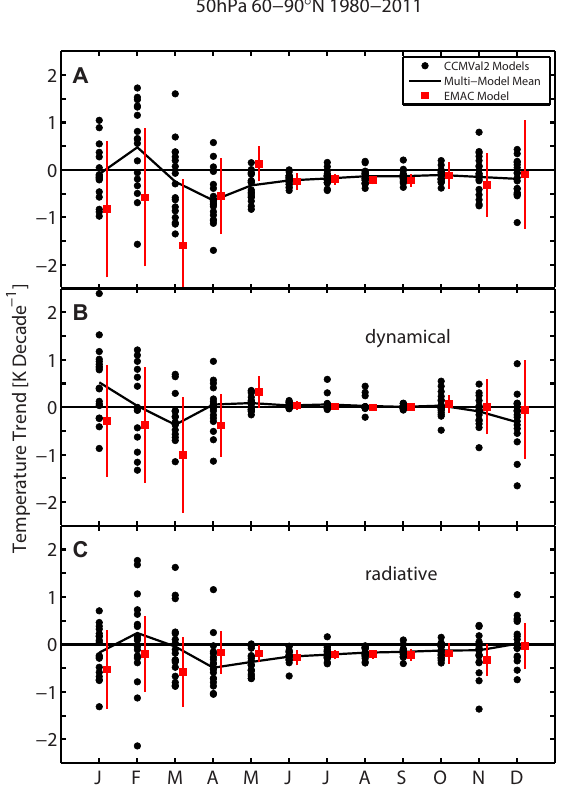
Fig. 3. Arctic temperature trends per decade at 50hPa for each month from EMAC (red) and CCMVal2 models (black) for the years 1980–2011. The figure shows the area-weighted average over 60–90 ◦ N. (A) Temperature trend. (B) Dynamical component of the trend. (C) Residual radiative component of the trend. Vertical bars show the 2 σ